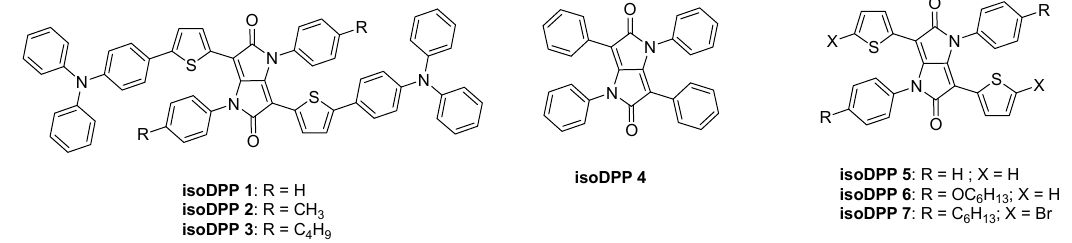
Figure 3. Structures of small molecular based on isoDPP.